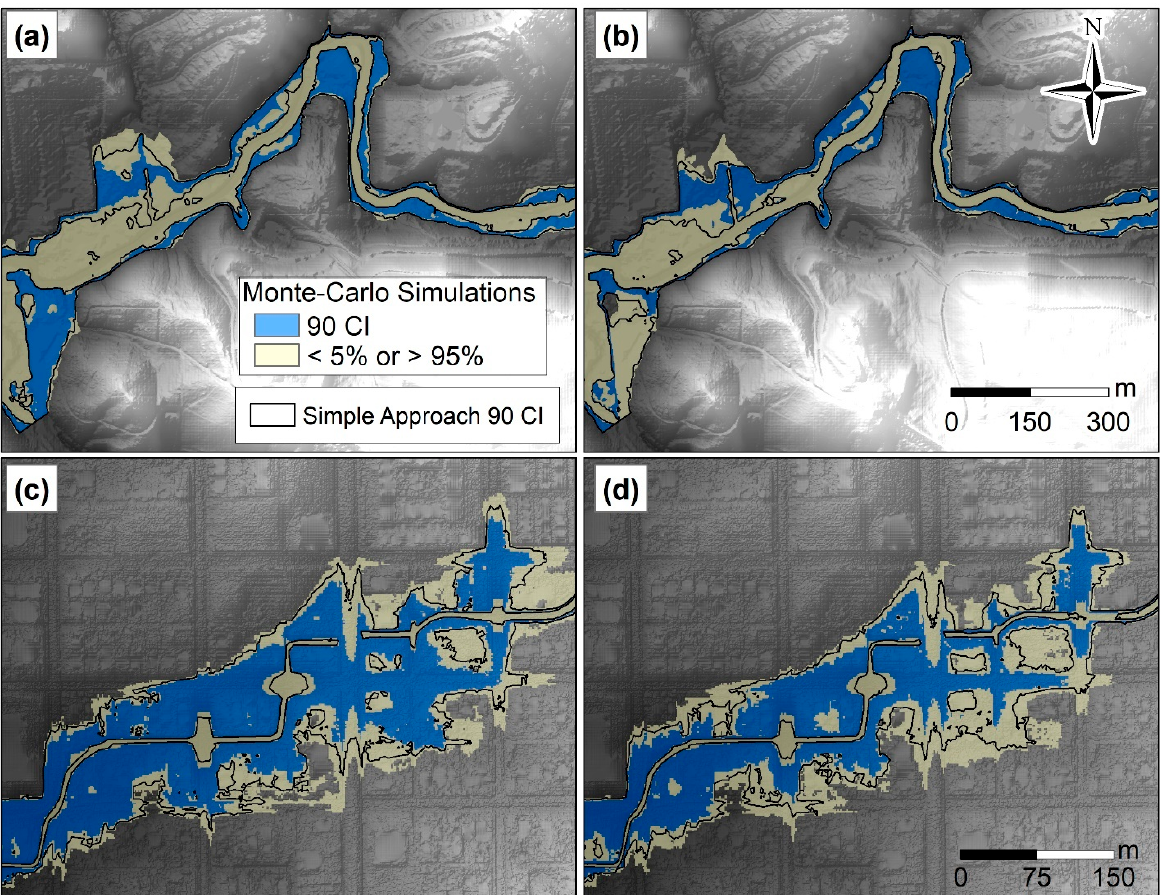
Figure 3. 90% confidence intervals (CI) of flood inundation estimated by MCS and the SUB for ( a ) the 1% AEP flood at Proctor Creek, ( b ) the 2% AEP flood at Proctor Creek, ( c ) the 1% AEP flood at Bronx Wash, and ( d ) the 2% AEP flood at Bronx Wash. The 90% CI indicate areas that have a 5–95% chance of being inundated by the flood with a specific AEP.